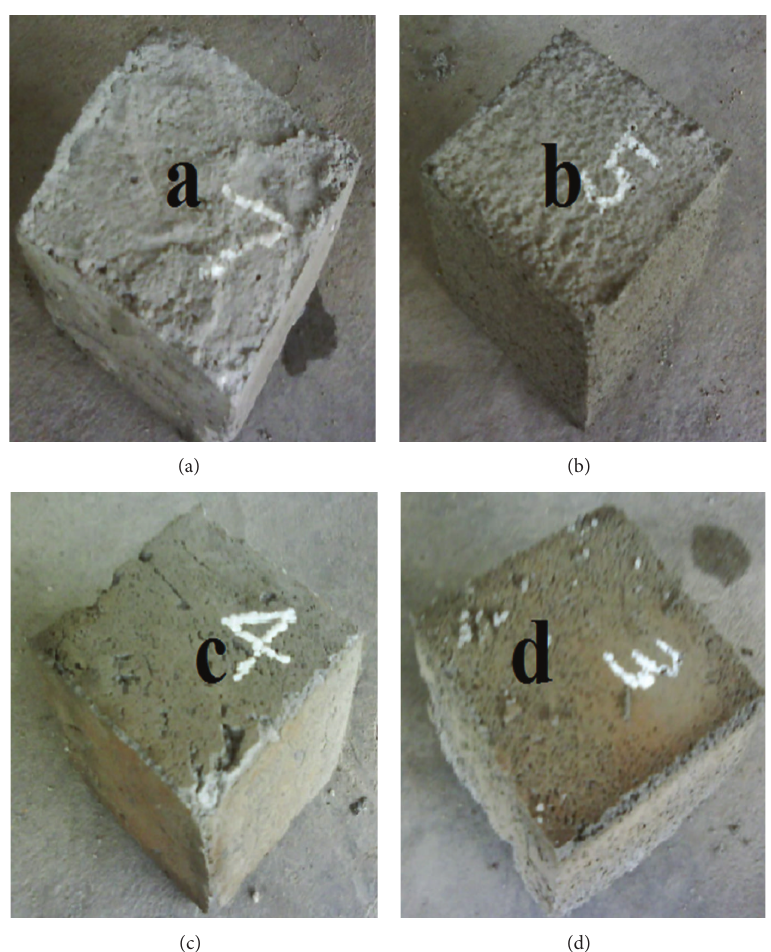
Figure 1: Samples of LC for cube test with different WLA proportion ratio: (a) 0.55, (b) 0.60, (c) 0.65, and (d) 0.70